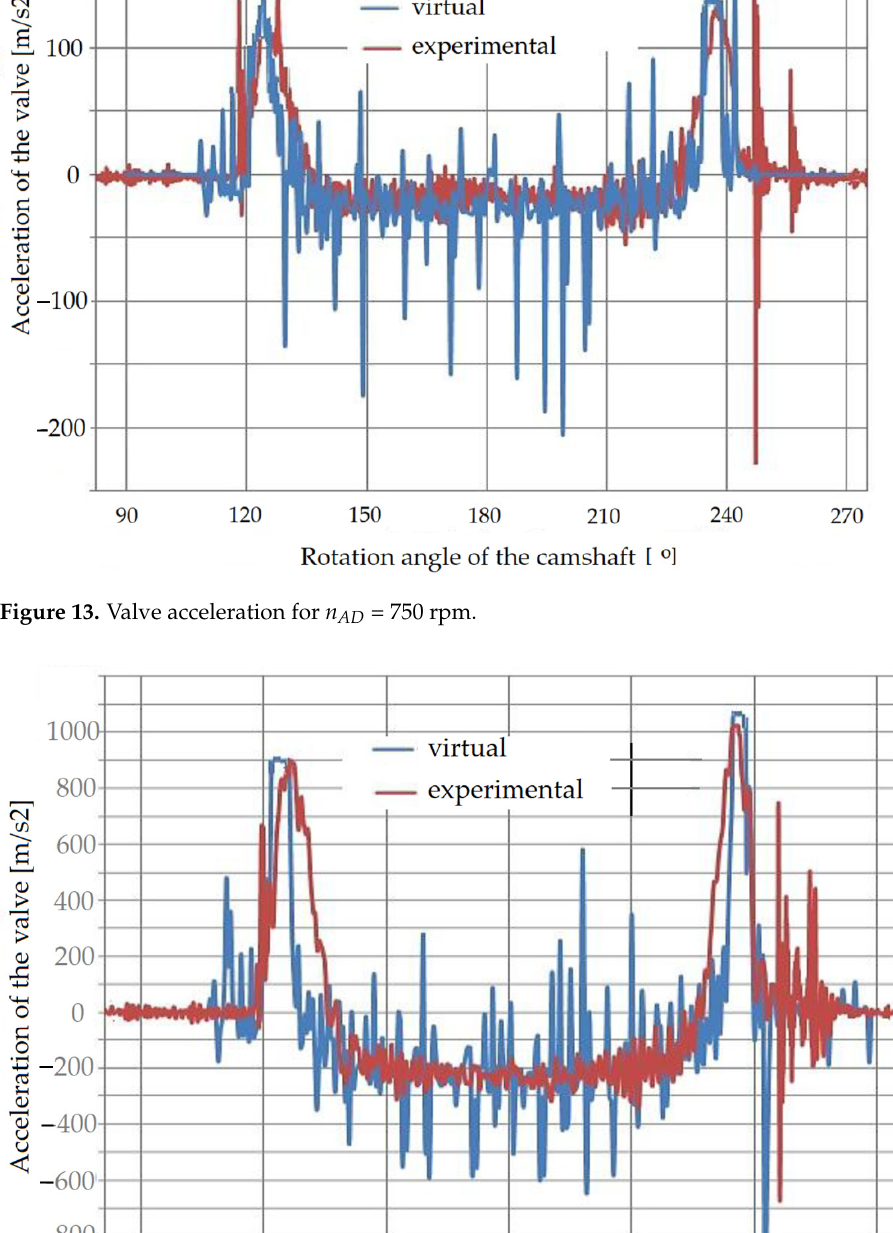
Figure 12. Valve acceleration for n AD = 350 rpm.